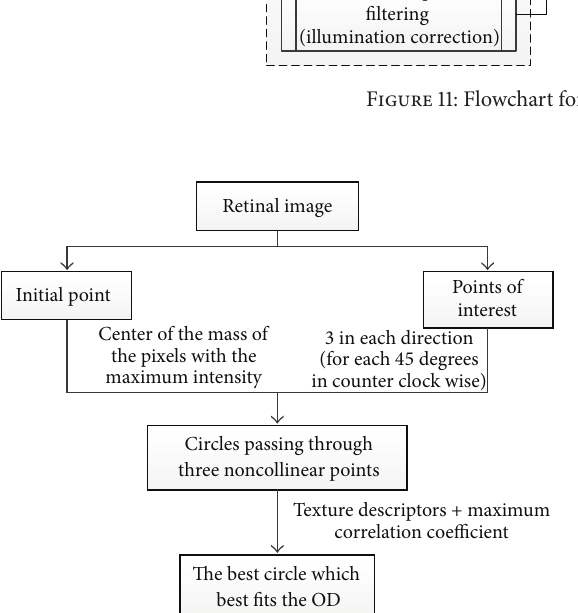
Figure 12: Flowchart for algorithm proposed in [29].